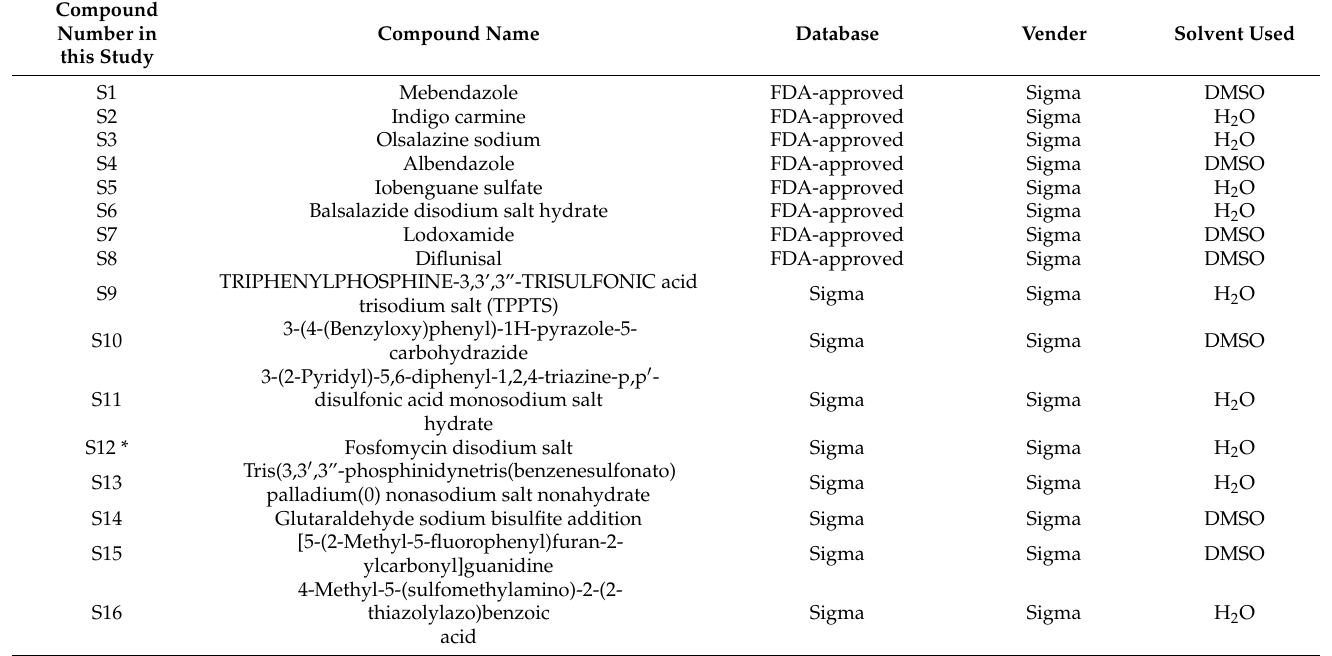
Table A1. Information of selected compounds to be experimentally